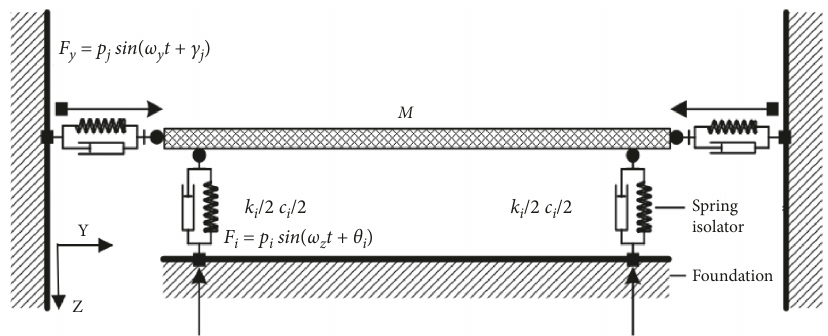
Figure 2: Multi-dimensional vibration isolation system (Side